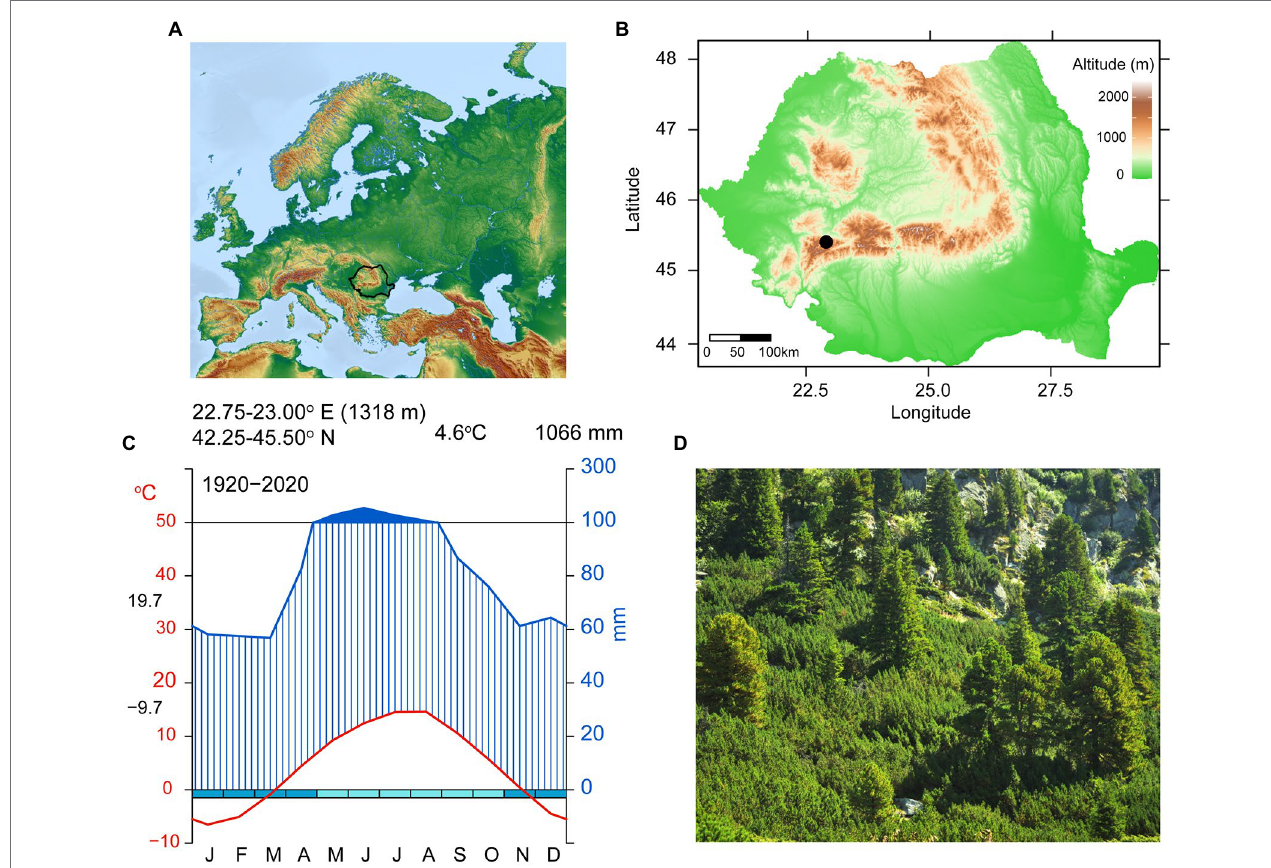
FIGURE 1 | Site location (A) Map of Europe—black contour is Romania; (B) Map of Romania—black dot shows Retezat National Park location; (C) Walter–Lieth Climodiagram showing mean monthly precipitation (blue, mm), mean monthly temperature (red, ° C), months in which frost events are likely to occur (light-blue and turquoise boxes) and wet periods (dark-blue filled areas) based on grided data; (D) General view of the sampling